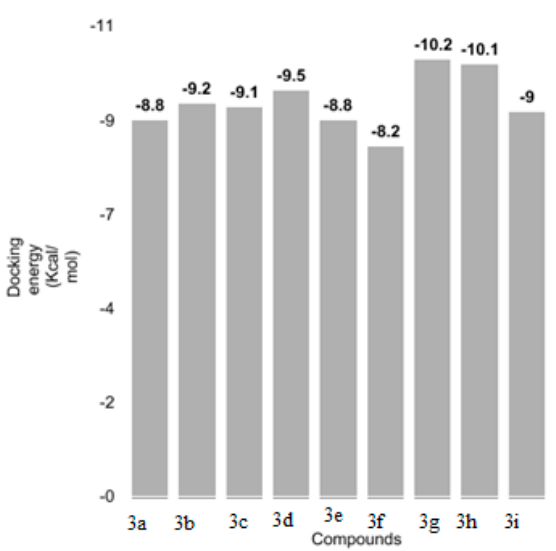
Figure 4. Docking energy values of all the synthesized docked compounds.